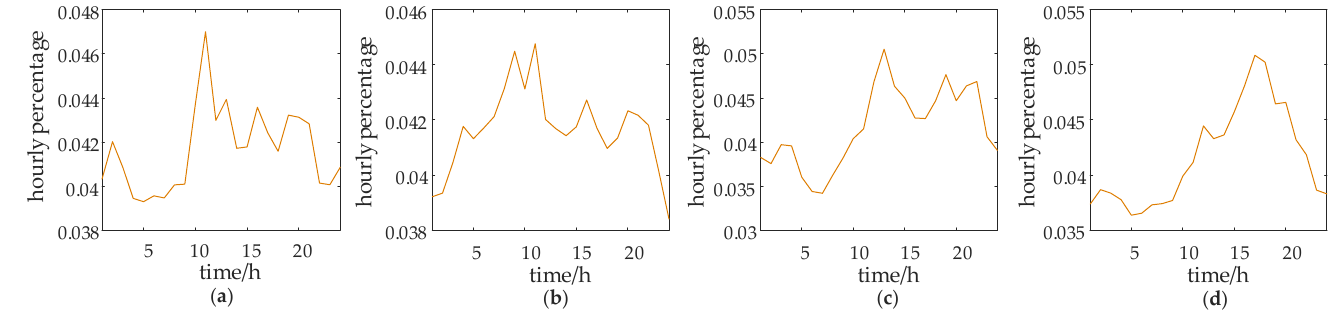
Figure 7. Hourly percentage of electric load in four seasons. ( a ) spring; ( b ) summer; ( c ) autumn; ( d ) winter.